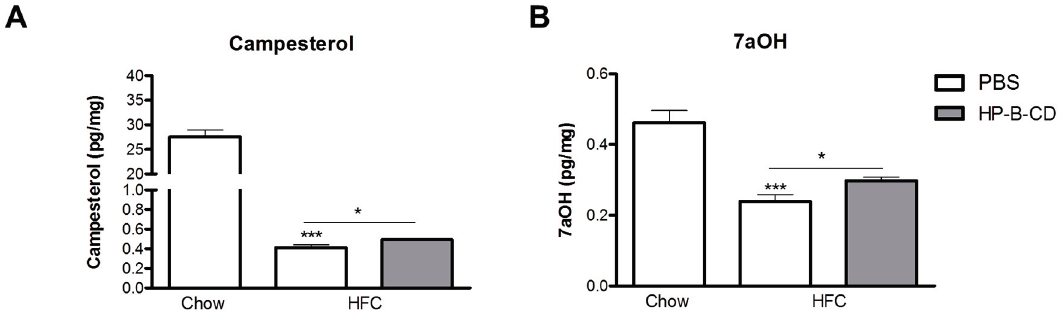
Figure 4. Hepatic levels of campesterol and 7 α -hydroxycholesterol (7aOH). Campesterol ( A ) and 7aOH ( B ) were analyzed in liver pieces of Ldlr − / − mice after 12 weeks of regular n = 12 for the mice fed an HFC diet without treatment; n = 12 for the HFC-fed mice